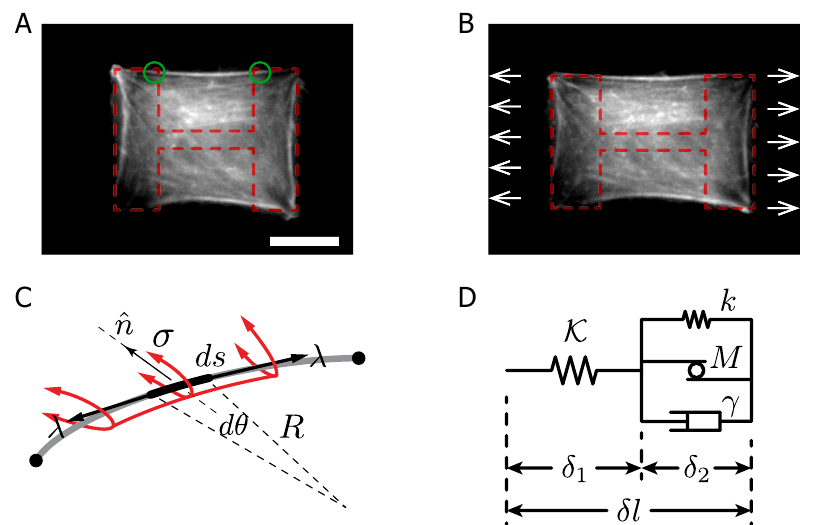
Figure 1. F-actin-labeled RPE-1 cells on PLL-g-PEG/fibronectin patterns. ( A , B ) Cells with main F-actin bundles at the free edge before stretch and the same cell after 15 min at a constant stretch (H-like pattern is displayed on segmented red lines, while the green circles target the FAs location). The experimental apparatus stretches the PDMS substrate, exerting tension on the cell and the stress fibers as well. Scale bar 20 µ m. ( C ) Sketch of an F-actin bundle between two anchored points (FAs), with radius of curvature R , cortical tension σ and the line tension λ along the bundle. ( D ) Mechanical representation of the